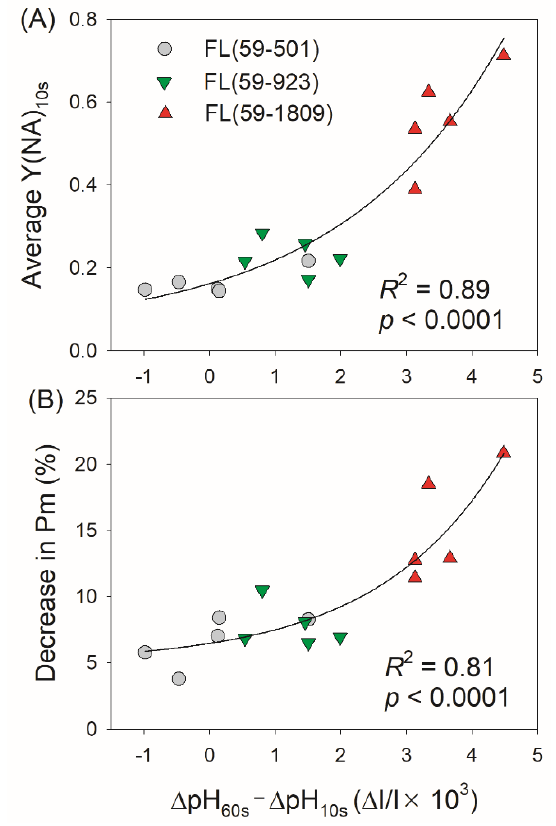
Figure 6. Effects of the delaying formation of ∆ pH ( ∆ pH 60 s − ∆ pH 10 s ) on PSI redox state ( A ) and PSI photoinhibition ( B ) under different fluctuating light conditions. Each plot represents the data of an individual leaf. Exponential growth model ( y = y 0 + ae bx ) was used to fit the relationships.